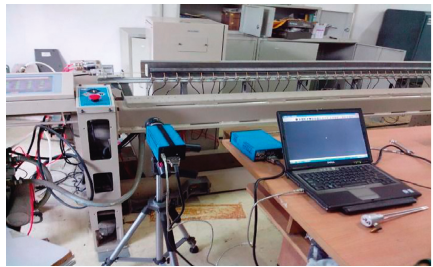
Figure 5: Test equipment of the experiment.